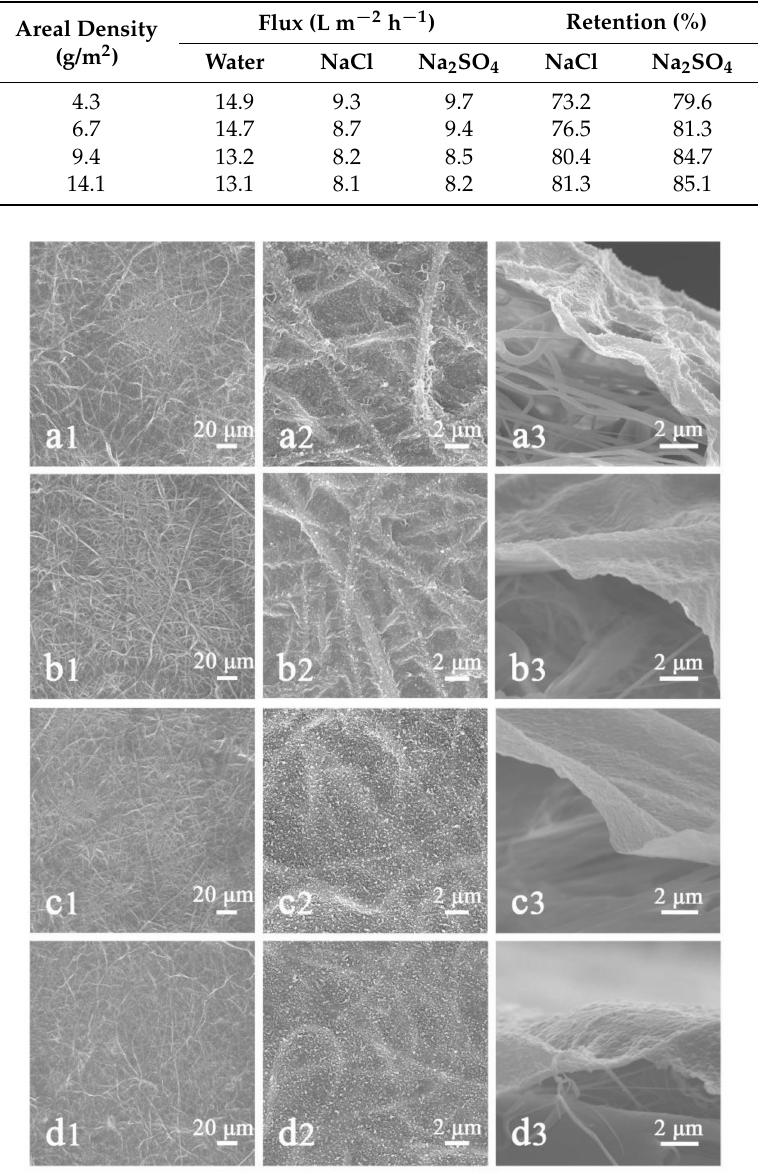
Figure 9. SEM images of surface and cross-section of NFNFM prepared by different areal densities of HNM: ( a1 – a3 ) 4.3 g/m 2 , ( b1 – b3 ) 6.7 g/m 2 , ( c1 – c3 ) 9.4 g/m 2 , ( d1 – d3 ) 14.1 g/m